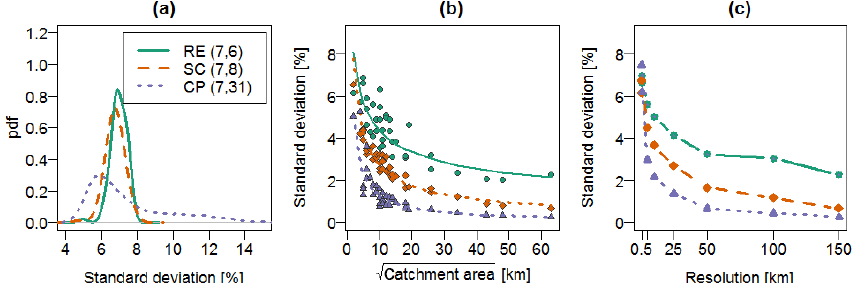
Figure 5. (a) Probability distribution of the standard deviation of the clay percentage based on 100 realizations of the soil map calculated for all grid cells and each method (RE is random error method, SC is spatially correlated method and CP is conditional points method). The mean and coefficient of variation of the distribution are indicated in brackets. (b) Standard deviation calculated by aggregating the clay percentage at subcatchments with different size. (c) Standard deviation calculated by aggregating the clay percentage at different grid